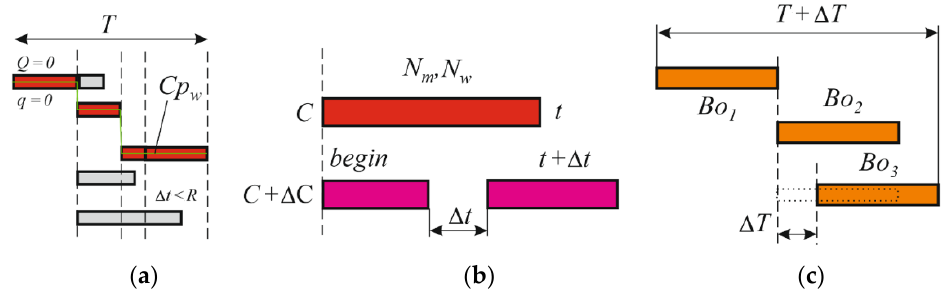
Figure 2. Construction work scheduling options: ( a ) a single schedule; Cp w is the critical path for a schedule model that has no interruptions; T is the time of this critical path; Q , q 0 are general and specific slacks in the course of work performance; ( b ) simulation of interruptions in the process of work performance, included in the critical path; ( c ) construction of several facilities; Bo 1 − Bo 3 are durations of facility construction, ∆ T is simulation of process interruptions.